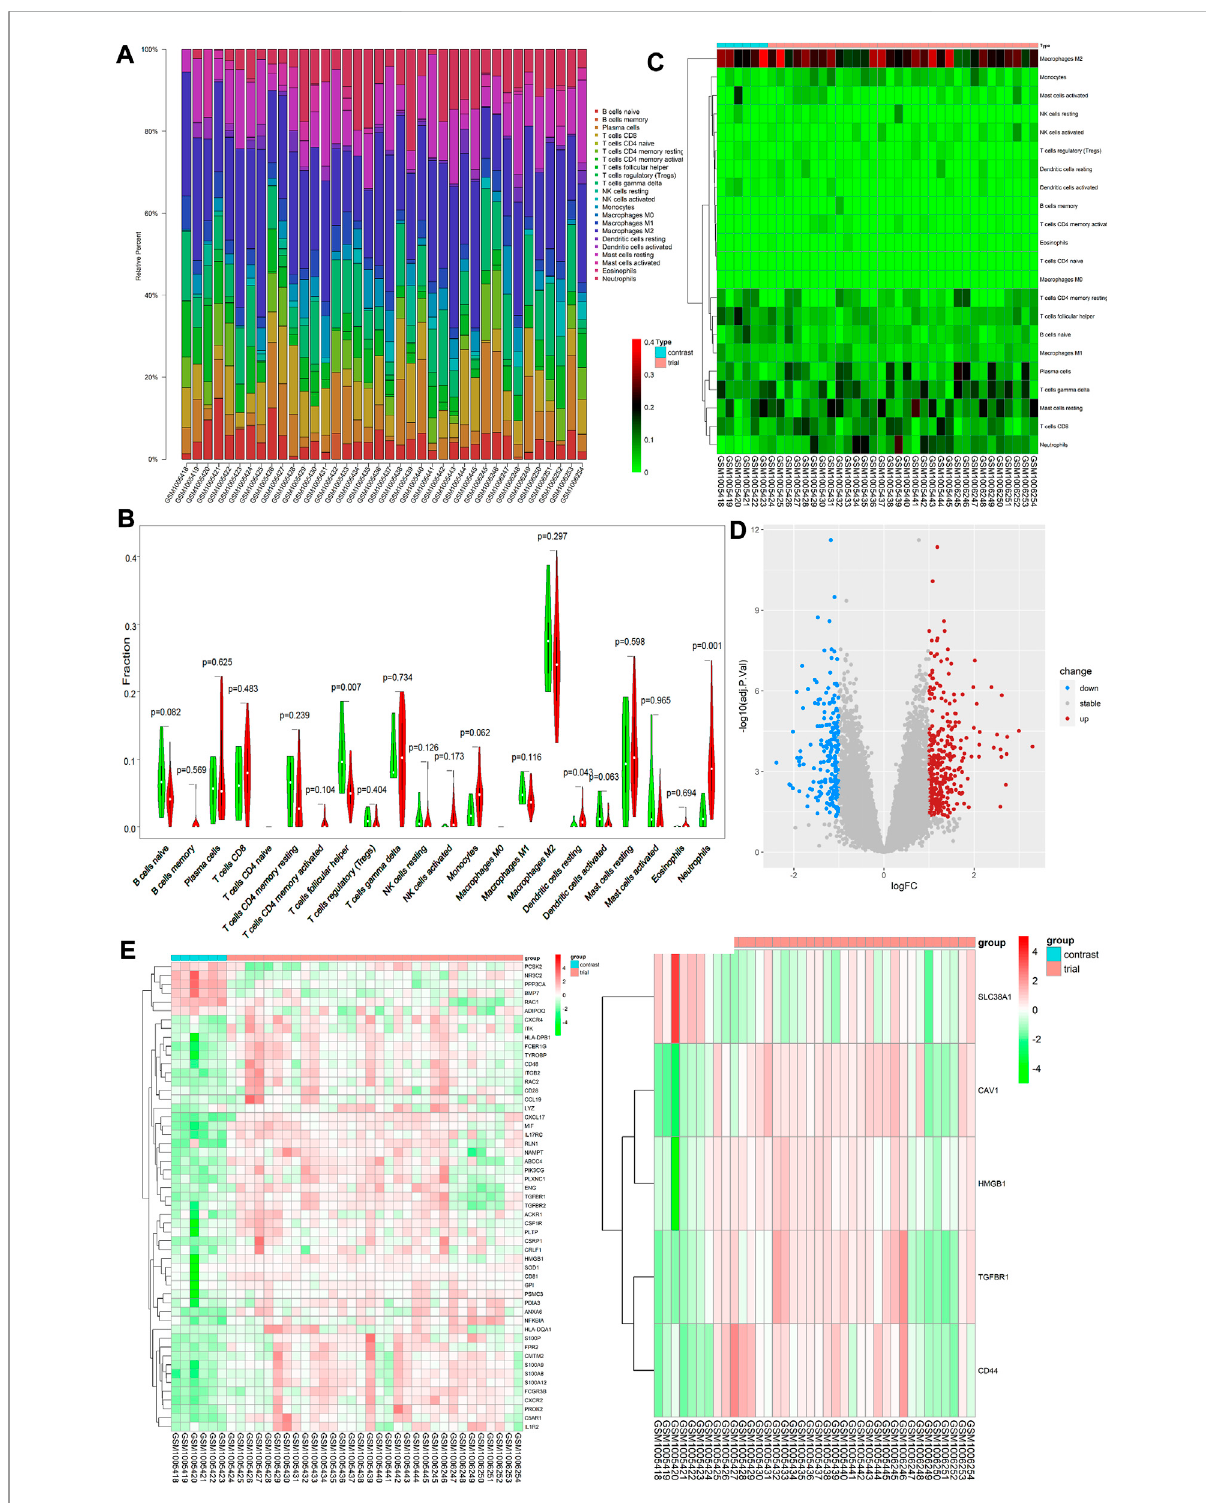
FIGURE 1 (A) Each bar represents a sample, and each color represents a type of immune cell. Area of the color represents the percentage of immune cell in fi ltration responsible for total immune cell in fi ltration. (B) Each column represents a sample, and each row represents a type of immune cell. Color transitionfromgreentoredrepresentsanincreaseinimmunecellin fi ltrationlevel. (C) RedandgreenviolincolumnsrepresentpatientswithVAFand VSR, respectively. The vertical axis represents theratioof immune cell in fi ltration responsible for totalimmunecellin fi ltration. p value, obtained